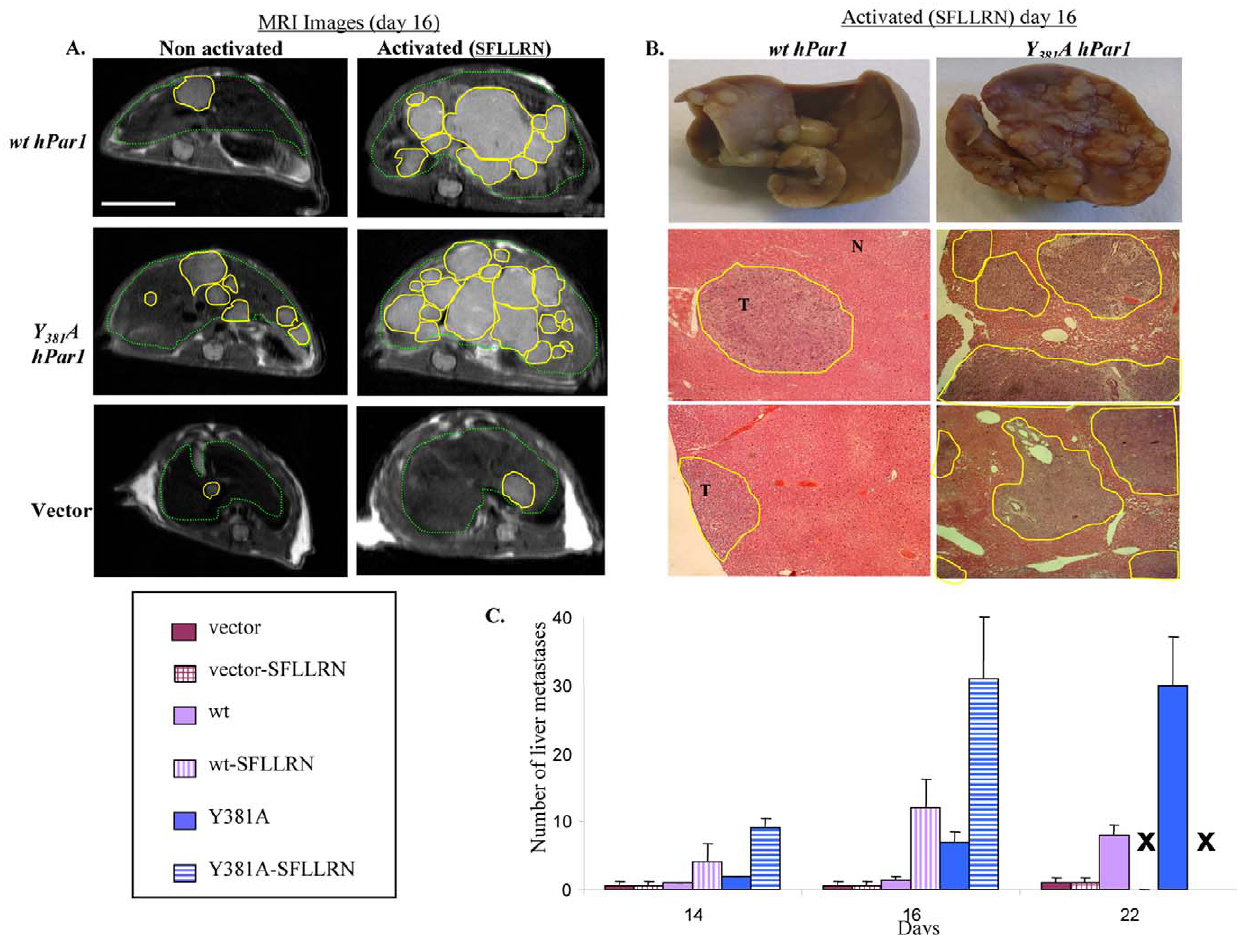
Figure 4. Y 381 AhPar1 construct enhances liver metastasis formation. A . MRI analysis . CT-26 mouse carcinoma cells (that do not express endogenous hPar1 ), ectopically forced to express either wt hPar1 or Y 381 A hPar1 constructs, were injected intra-splenically into CB6F1 mice to generate liver metastases. Tumor assessment was performed using T 2 W fast SE images (TR/TE=2000/40 ms). Representative axial liver sections of wt hPar1 or Y 381 A hPar1 CT-26-transfected cells, obtained at day 16, in the absence (left panel) or presence (right panel) of SFLLRN, are seen. Liver margins are marked with a dashed green line; yellow lines mark tumor foci; scale bar represents a size of 1 cm and applies to all the images in A. B . Anatomical and histological examination. Gross anatomical photos (Top) and H&E staining of liver sections (harvested on day 16) of activated wt hPar1 or Y 381 A hPar1 CT-26 cells. T=tumor and N=normal; yellow lines mark tumor foci; original magnification 6 100. C. Histogram of the number of liver metastases per mouse as measured by MRI. The experiments were performed in the presence or absence of the PAR 1 agonist peptide (n=3– 5 mice/group). Activation of PAR 1 accelerated both tumor size and the number of detectable foci as well as their time of appearance. X stands for sacrificed mice with overloaded liver